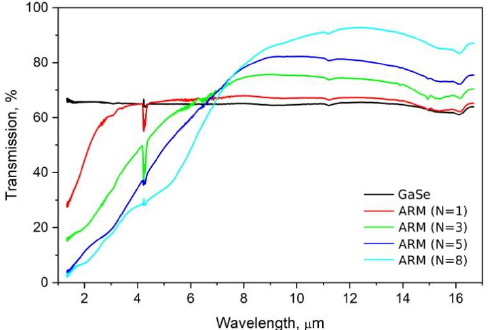
Figure 10. Transmission spectra of the ARM inscribed on both sides of the GaSe sample at E = 37.5 nJ. Single crater of the ARM was obtained by impact of 1, 3, 5, and 8 laser pulses. The transmission spectrum of the initial GaSe sample is shown by a black line for a comparison.